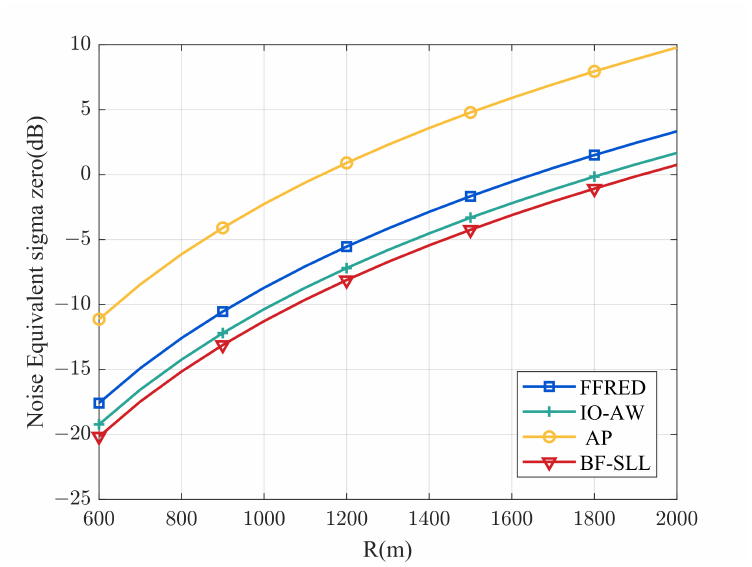
Figure 6. Noise equivalent sigma zero versus the range of different